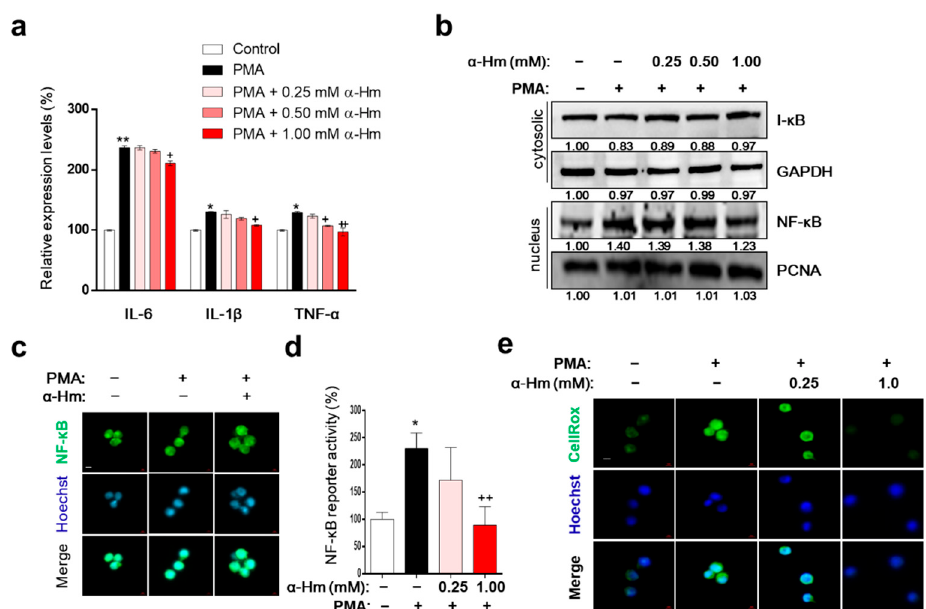
Figure 5. α -Humulene inhibits inflammation-related factors in PMA-stimulated HMC-1 cells. ( a ) mRNA expression levels of inflammatory cytokine genes interleukin (IL)-1 β , tumor necrosis factor- α (TNF- α ), and IL-6. HMC-1 cells were pretreated in the absence or presence of α -humulene ( α -Hm) for 4 h and incubated with PMA (20 ng/ml) for 1 h. Glyceraldehyde 3-phosphate dehydrogenase (GAPDH) was used as the internal control. ( b ) Nuclear and cytosolic protein expression levels of nuclear factor kappa-light-chain-enhancer of activated B cells (NF- κ B) and inhibitor of nuclear factor kappa B (I- κ B). ( c ) Immunofluorescence staining of NF- κ B in HMC-1 cells. Nuclei were stained with Hoechst 33342 (blue) and NF- κ B was detected with anti-NF- κ B antibody (green). All images are 40 × magnification. ( d ) Transcriptional activity of NF- κ B using luciferase reporter systems. ( e ) Effect of α -humulene on reactive oxygen species (ROS) production. The intensity of CellROX signal (a cell permeable fluorescent reagent for detecting oxidative stress, green) correlated with the amount of ROS. + p < 0.05, ++ p < 0.01, * p < 0.05, ** p < 0.01.